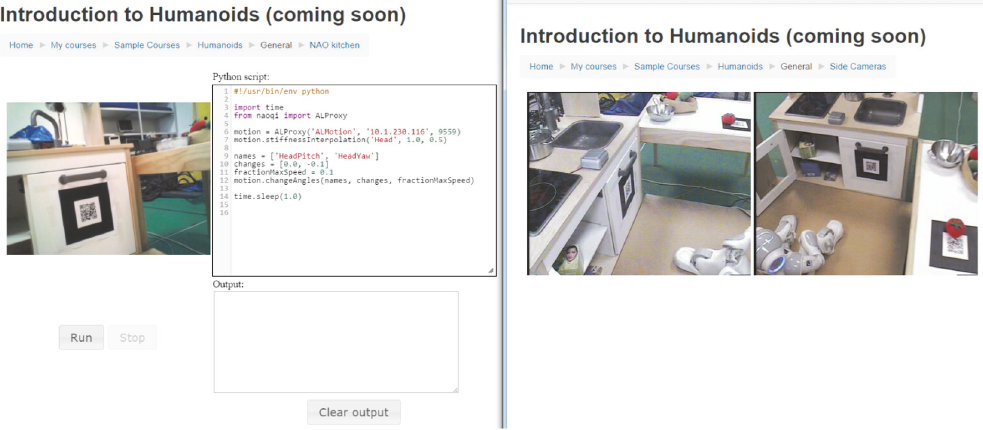
Figure 6: Left subwindow, programming environment with a vision through the robot camera. Right subwindow, images of the environment of the robot through two external cameras, from the HUMABOT 2014